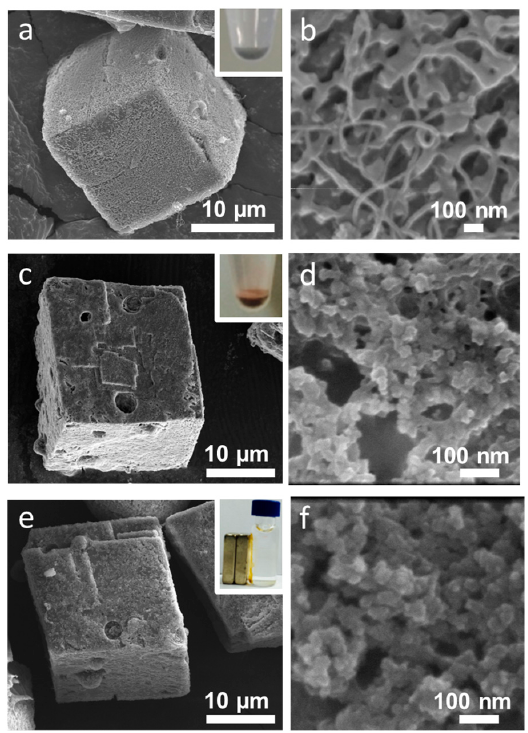
Figure 9. SEM images showing the functionalization of ( a , b ) carbon nanotubes (CNTs); ( c , d ) Au nanoparticles; and ( e , f ) Fe 3 O 4 nanoparticles on polymer-coated CaCO 3 crystals.